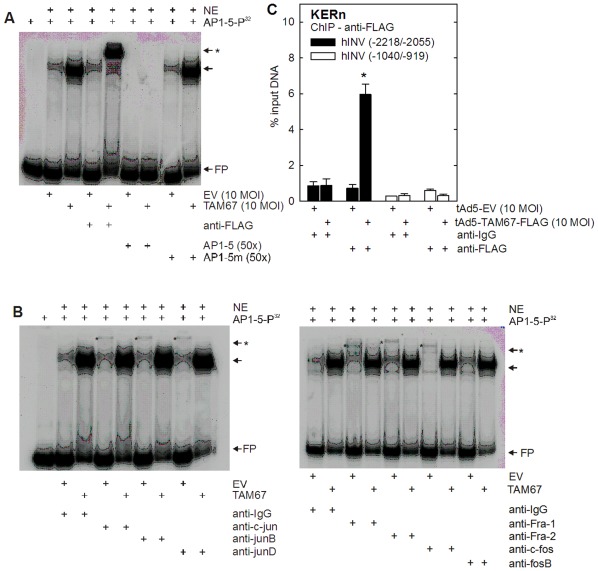
TAM67 binds to the AP1-5 site of hINV gene promoter.Keratinocytes were infected with 10 MOI tAd5-EV or tAd5-TAM67-FLAG and after 24 h nuclear extracts were prepared for gel shift. A TAM67 interaction with hINV promoter AP1-5 site. Nuclear extracts were incubated with AP1-5-P32 with or without a 50-fold molar excess of AP1-5 or AP1-5 m oligonucleotide, or anti-FLAG antibody, and electrophoresed on a 6% acrylamide non-denaturing gel. FP indicates free probe and NE is nuclear extract. The arrow indicates the major shifted bands and asterisks indicate supershifted bands. AP1-5 is an oligonucleotide encoding the AP1-5 site of hINV promoter. AP1-5 m is an AP1-5 mutant that does not bind AP1 transcription factors [47]. B TAM67 inhibits AP1 factor interaction with AP1-5. Nuclear extracts were incubated with AP1-5-P32 in the absence or presence of c-jun, junB, junD, Fra-1, Fra-2, c-fos, or fosB specific antibodies, and electrophoresed on a 6% acrylamide non-denaturing gel. Arrows indicate major shifted band and asterisks indicate supershifted bands. FP is free probe. C ChIP analysis reveals TAM67 presence at the hINV upstream regulatory region AP1-5 site in vivo. Nuclear extracts were prepared for ChIP analysis and incubated with anti-IgG or anti-FLAG and the precipitated DNA was analyzed for AP1-5 site encoding sequences. The values are mean ± SD (n = 3, p<0.001) and the asterisk indicates a significant increase compared to all other groups. Nucleotides −2218/−2055 encodes the AP1-5 site and nucleotides −1040/−919 is a region of the hINV upstream regulatory region that lacks an AP1 site.